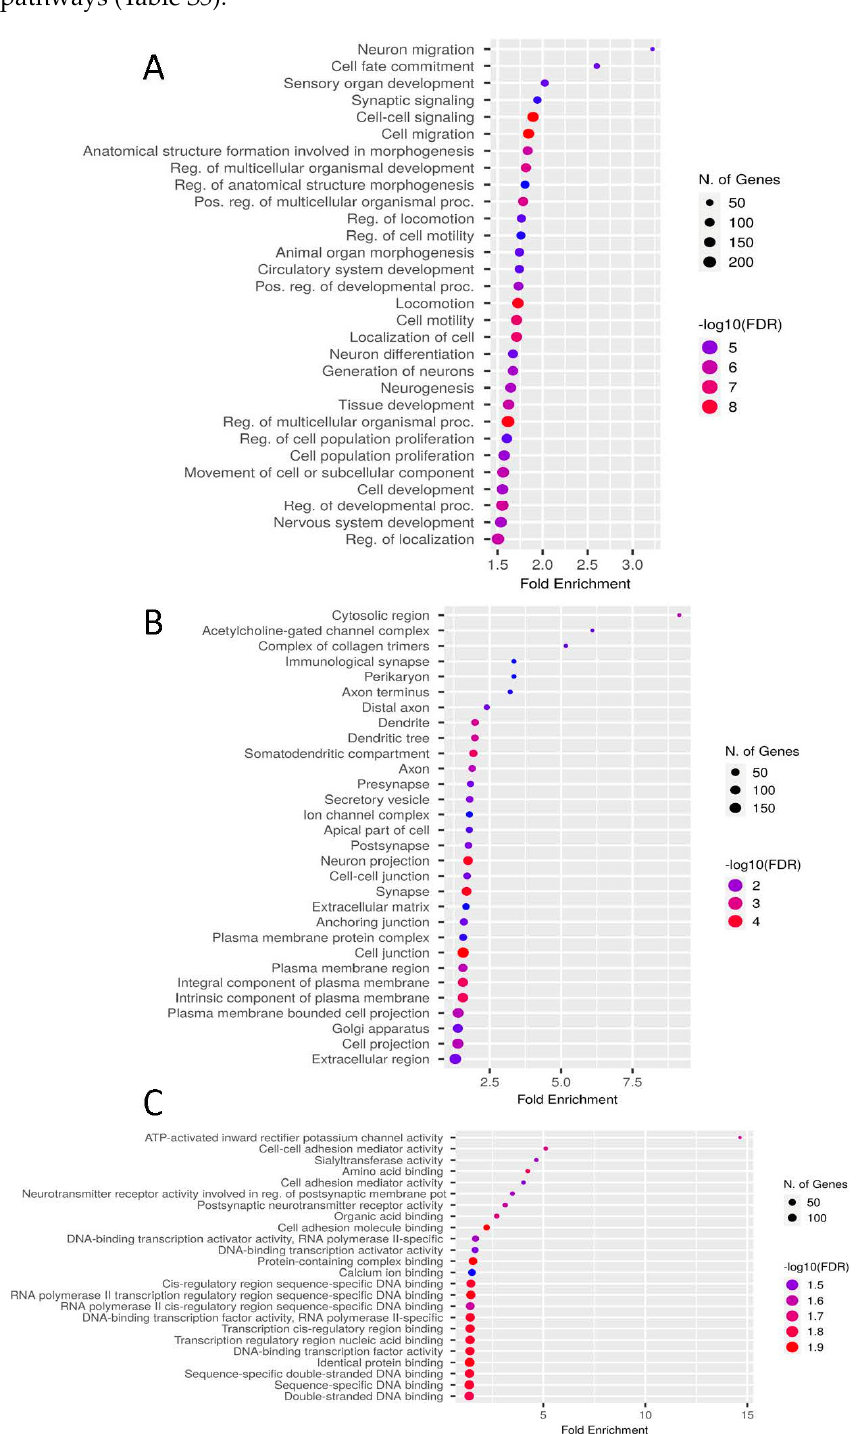
Figure 4. GO enrichment results for the butyrate-induced differentially CTCF-binding sites show the top GO terms for ( A ) biological process, ( B ) cellular component, and ( C ) molecular function. Biological processes are ranked according to the fold enrichment values. Bubble colors represent the p -value of the False Discovery Rate (FDR). The most important processes are highlighted in red, and the less important processes are highlighted in blue according to log 10 (FDR) values. Bubble sizes indicate the number of genes.